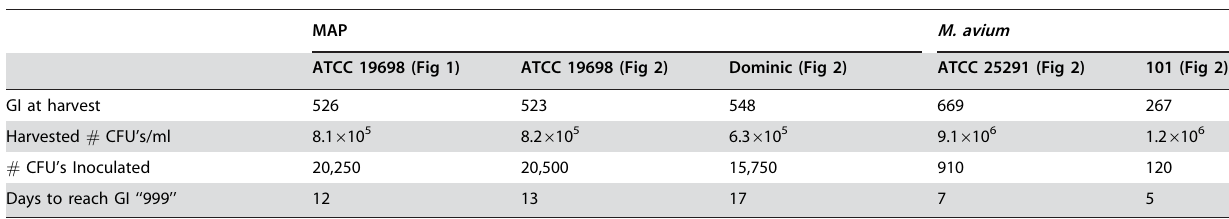
Table 1. Differences in growth kinetics and consequent length of experiment for each isolate. .. ... .... ... ... .... ... ... .... ... ... .... ... ... .... ... ... .... ... ... .... ... ... .... ... ... .... ... ... .... ... ... .... ... ... .... ... ... .... ... ... .... ... ... .